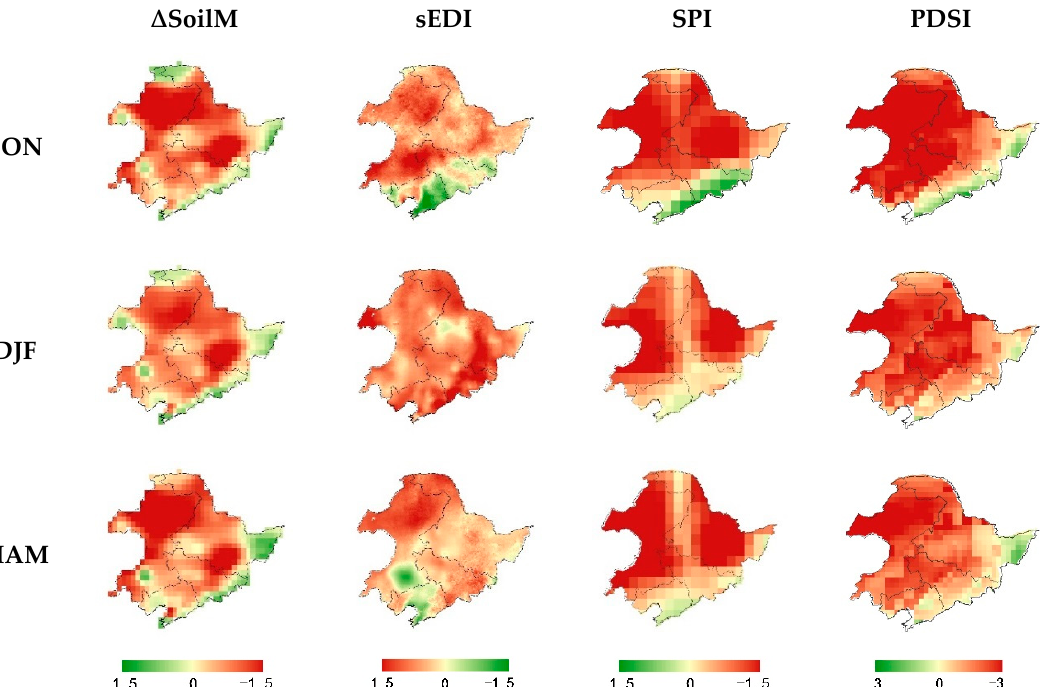
Figure 7. Seasonal standardized anomalies in SoilM, EDI, SPI, and PDSI from September 2007 to May 2008. Green indicates wetness and red indicates dryness. Drought was recorded in the whole Northeast China from December, 2007 to March,